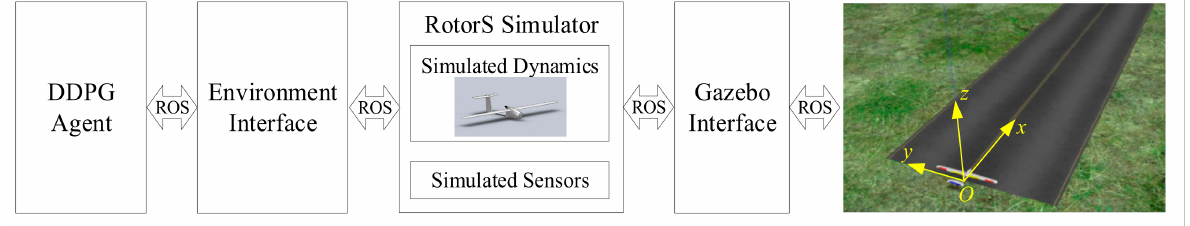
Figure 7. The simulation environment and setup.